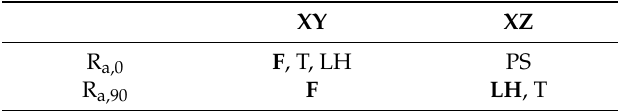
Table 10. Parameters involved in each data tree